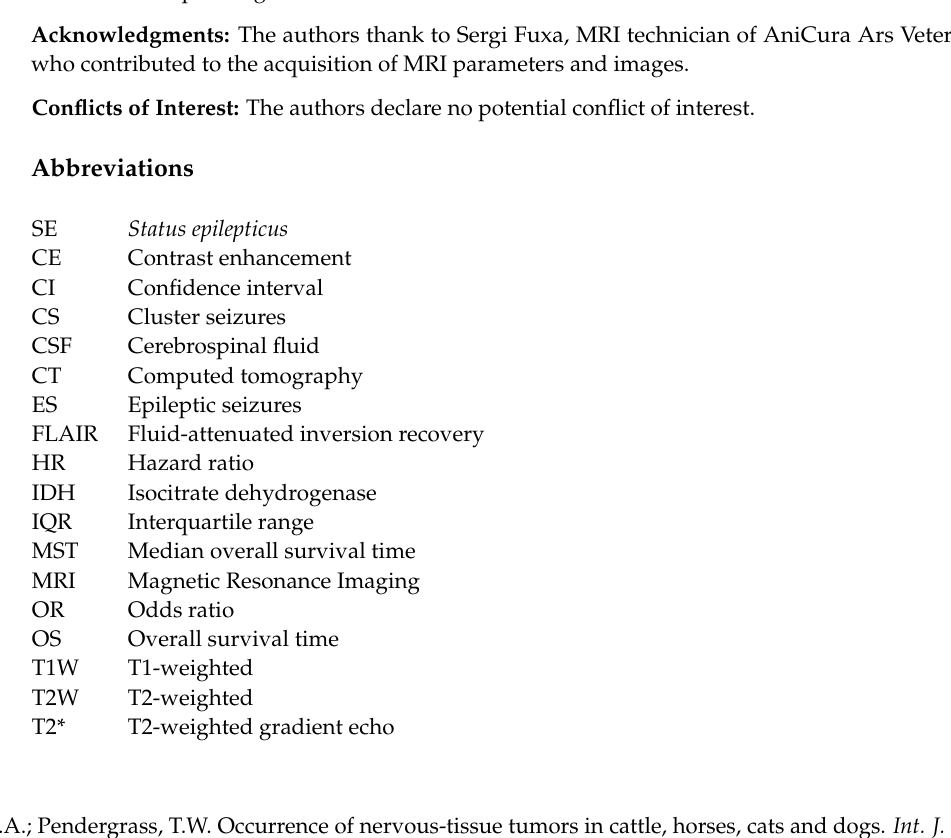
Table S2: Demographic and clinical characteristics of the study population; Table S3: Magnetic resonance imaging features of 60 suspected gliomas; Table S4: Univariable analysis of the relationship between demographic & clinical characteristics and MRI location. Table S5: Univariable analysis of the relationship between demographic & clinical characteristics and MRI-based high grade (all 60 dogs included); Table S6: Univariable survival analysis including 48 dogs with rostrotentorial gliomas; Table S7: Multivariable survival analysis including 48 dogs with rostrotentorial